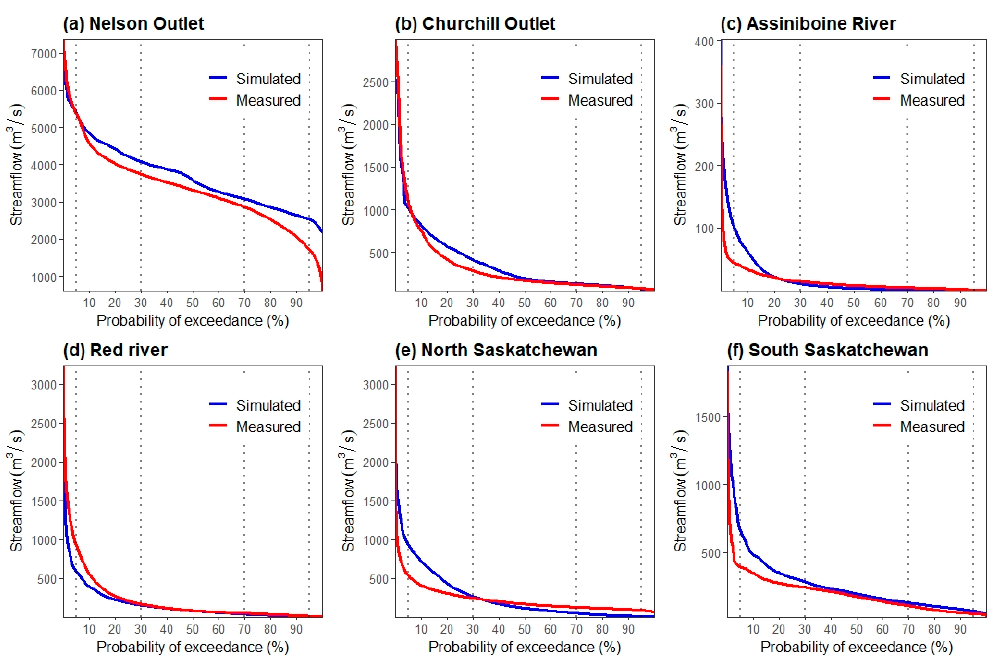
Figure 2. Flow duration curves of simulated streamflow simulated by HYPE using ensemble input data, and measured daily streamflow over 1981–2010 for the major rivers within the Nelson Churchill River Basin (NCRB).